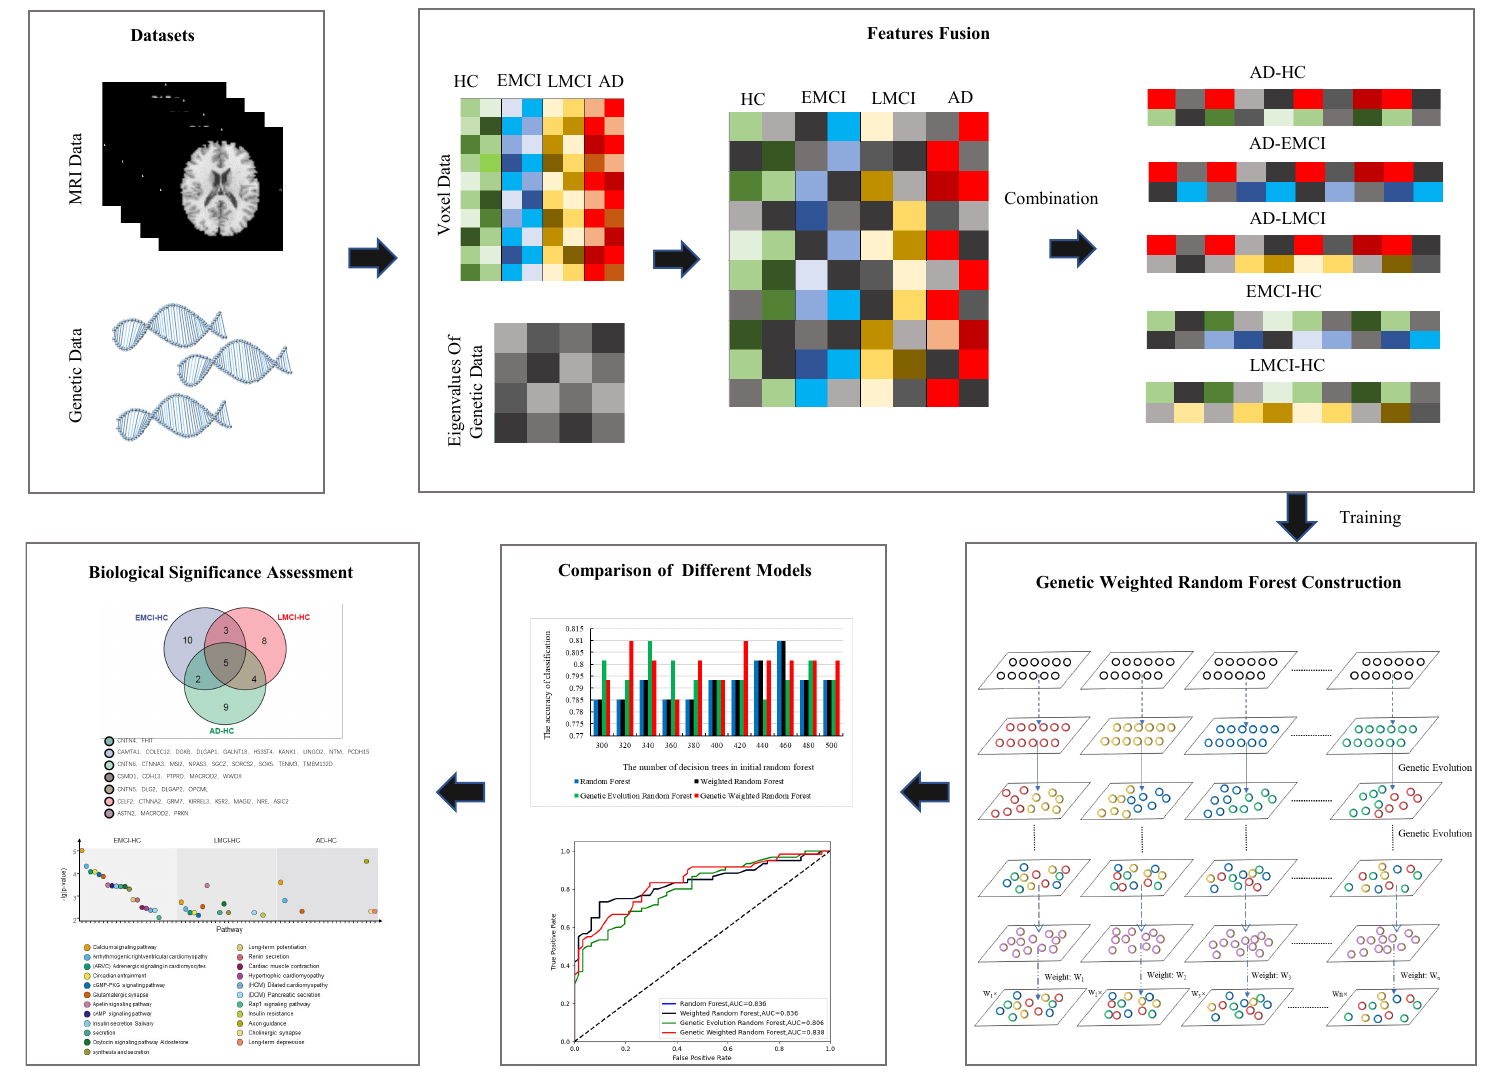
Figure 1. The workflow of the presented